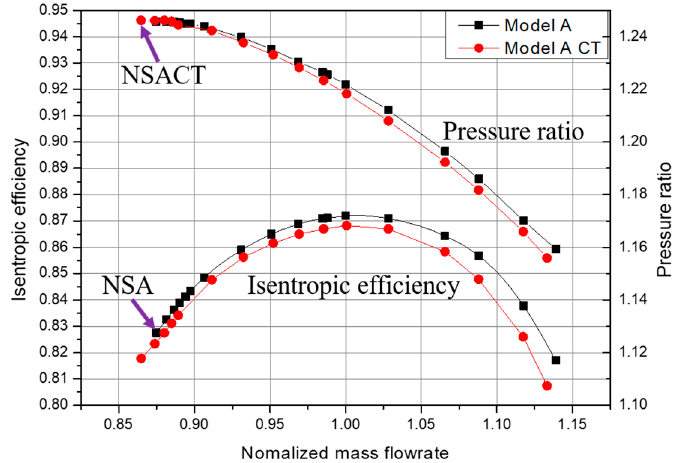
Figure 16. Pressure ratio and isentropic efficiency of a smooth solid wall and grooved casing treatment.